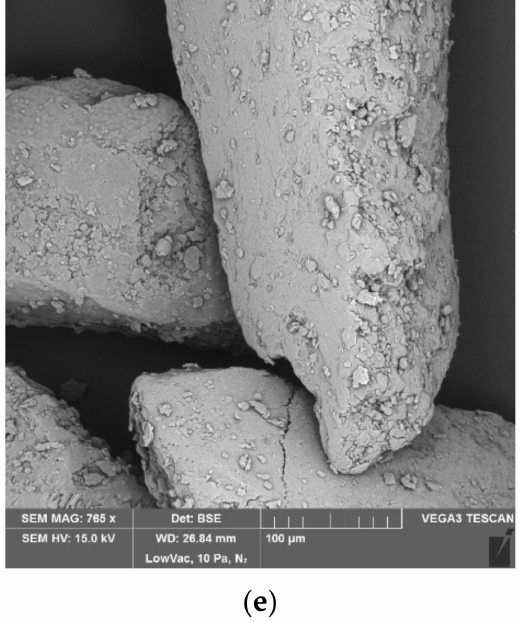
Figure 1. SEM of rice flours. ( a ) Black rice: compact polyhedral endosperm cells (50–100 µ m diameter) showing visible individual starch granules in the protein matrix. A few pieces of small clusters (10–30 µ m diameter) of starch granules and protein matrix; ( b ) Glutinous rice: large (50–80 µ m diameter) and small (<30 µ m diameter) endosperm cells of irregular shapes showing starch granules embedded in a protein matrix. Fragments of protein (<10 µ m diameter); ( c ) Red rice: endosperm cells (100–200 µ m) showing starch granules embedded tightly in the protein matrix. Individual starch granules are not visible. A few pieces of protein fragments (<15 µ m); ( d ) White rice—refined fine flour: large (70–100 µ m diameter) and small (<30 µ m diameter) endosperm cells of irregular shapes showing starch granules embedded in the protein matrix. Fragments of protein (<5 µ m diameter); ( e ) White rice—refined semi-coarse flour: Large blocks of endosperm (400–600 µ